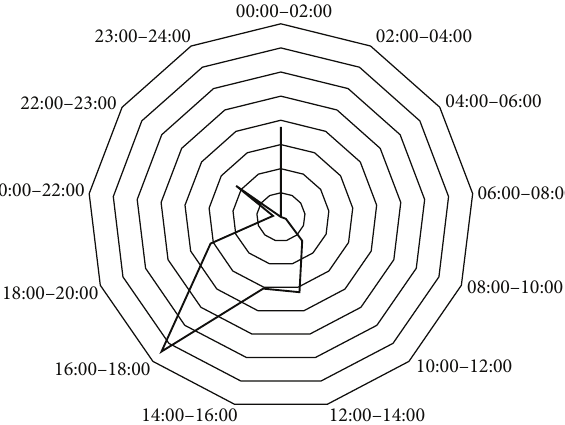
Figure 2: Response time differences around the clock. The largest mean response time difference (7min, 27 s) was observed between 16:00 and 18:00. Each polygonal division represents 1